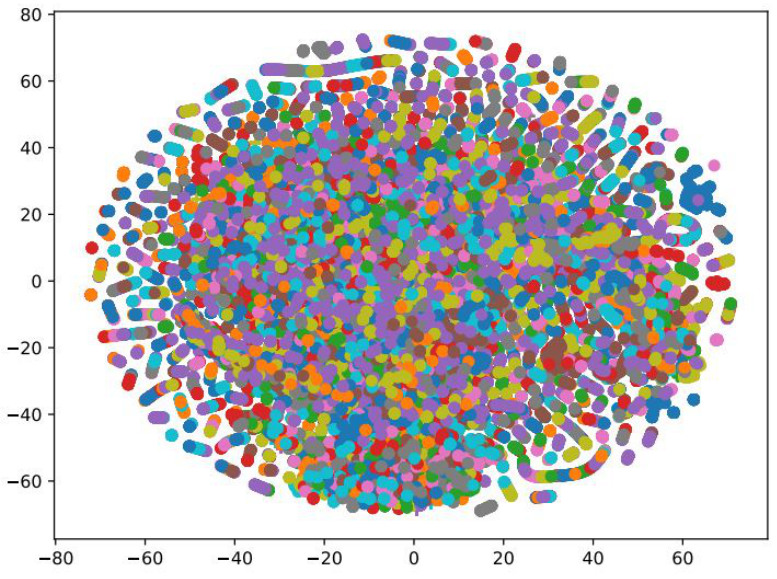
Figure 7. Visual classification of certificate attributes by Cert GCN. Different colors in the figure represent different documents, and each point represents an attribute of the document. There are 8061 digital certificate files in